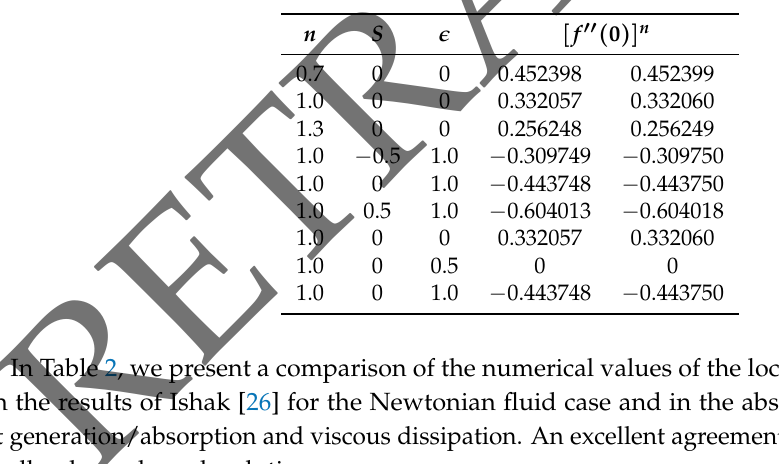
Table 1. Numerical values of the skin friction coefficient [ f (cid:48)(cid:48) ( 0 )] n for various values of n , S and (cid:101)